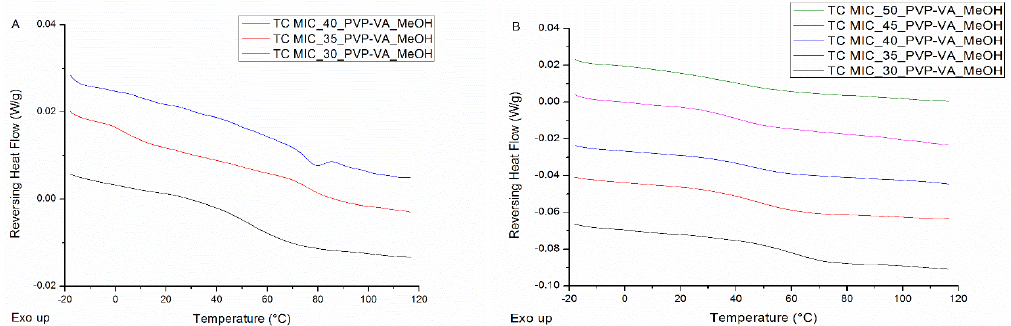
Figure 6. mDSC thermograms of ( A ) MCC tablets surface coated (TC) with MIC-PVP-VA, applying